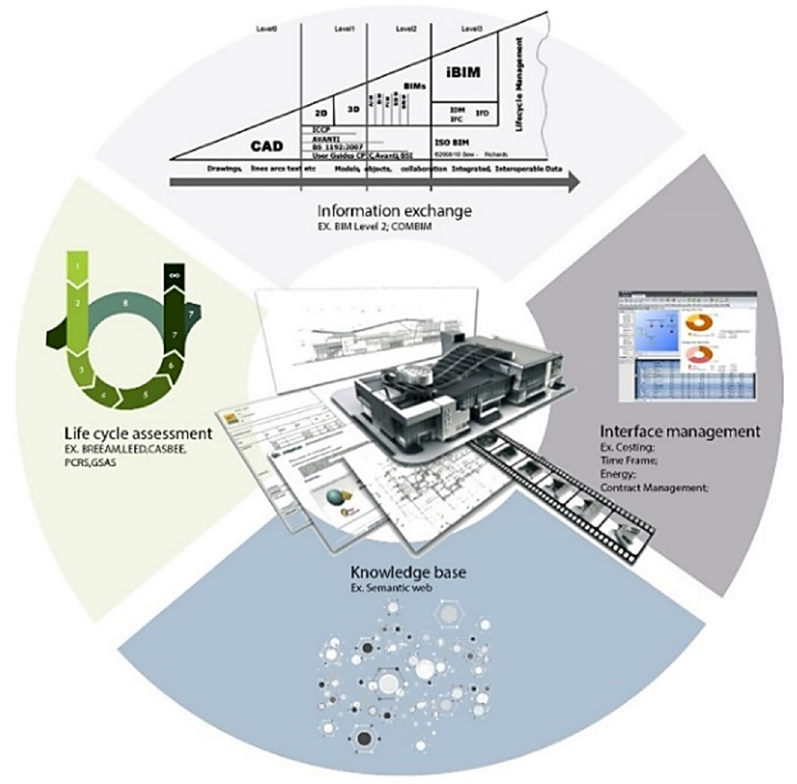
Figure 7. The concept of building information management (BIM).